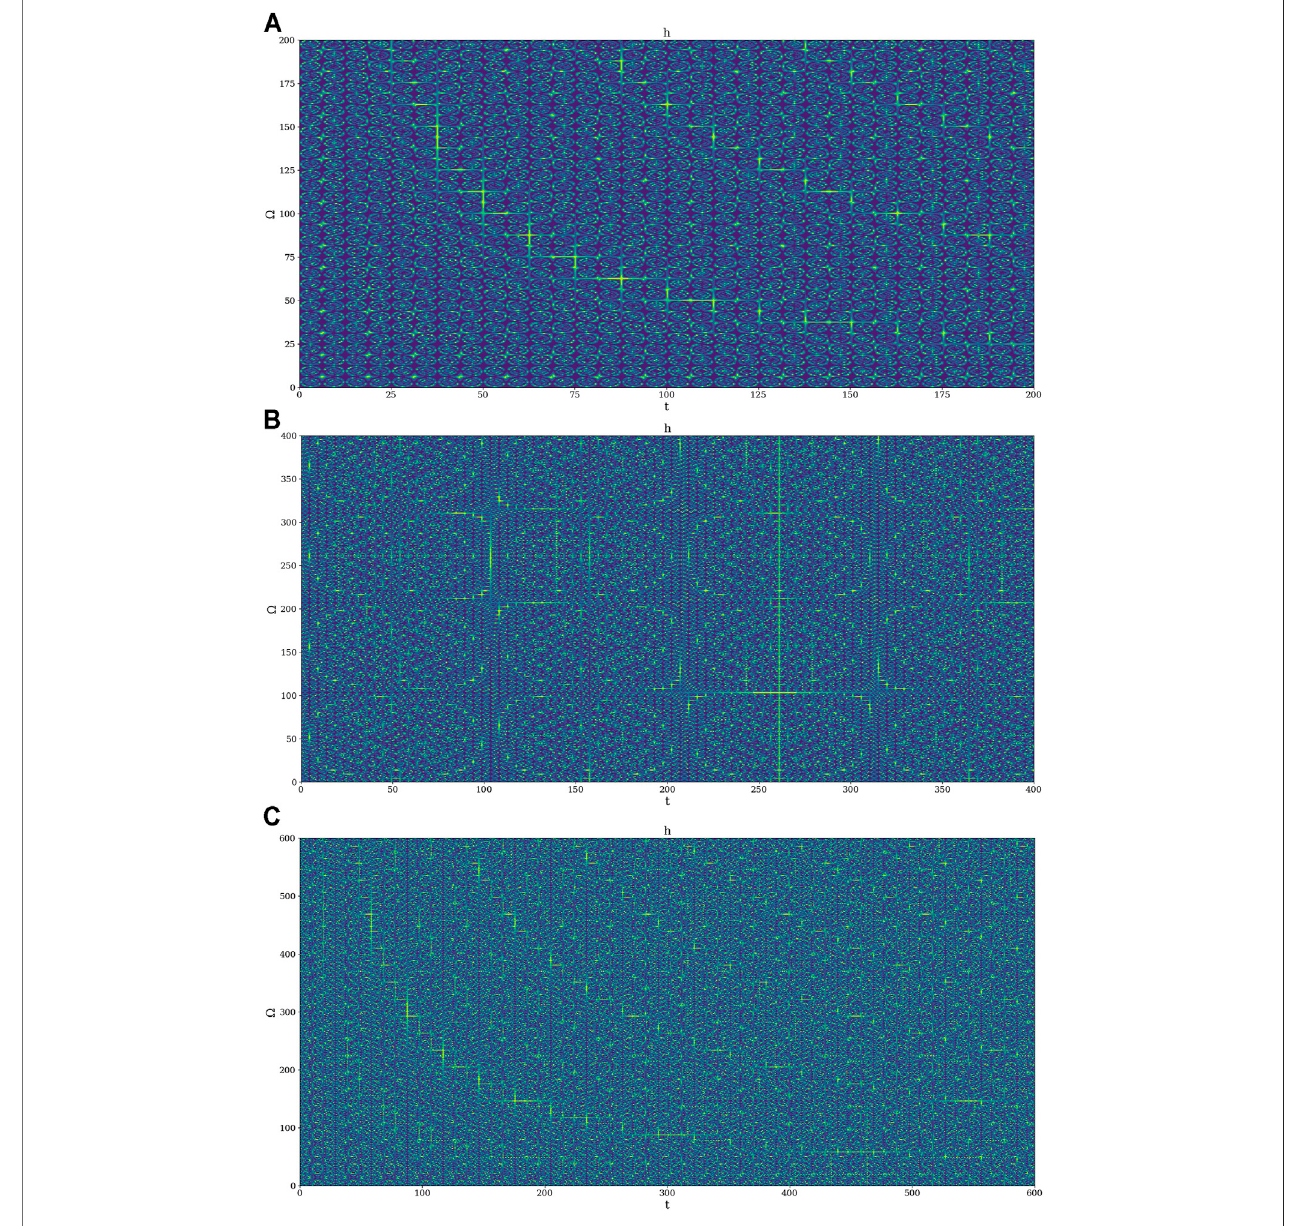
FIGURE 4 | Example 2D plot of h ( Ω , t ) ; (A) maximum at 200; Φ (cid:2) 2 . 35, (B) maximum at 400; Φ (cid:2) 2 . 35 and (C) maximum at 600; Φ (cid:2) 2 . 35.